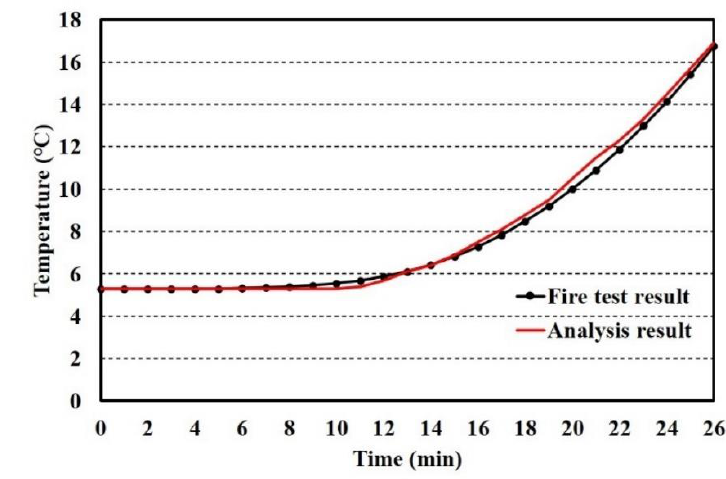
Figure 6. Comparison between fire test and analysis results.